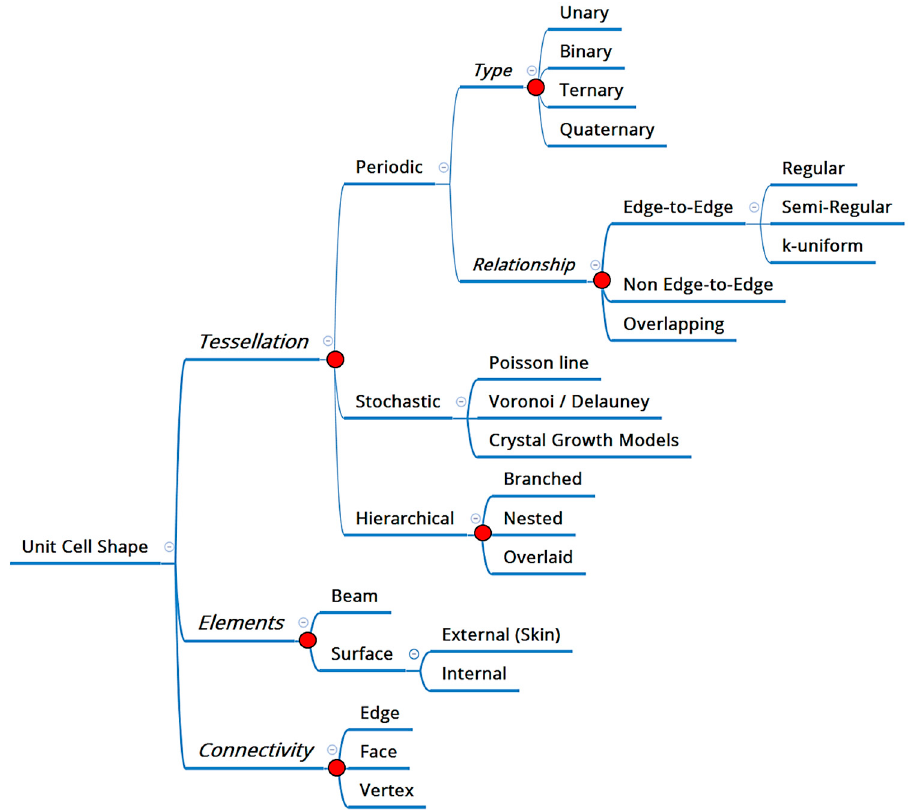
Figure 8. Cellular material classification developed by the authors from a synthesis of schemes from many domains. Each dot represents a decision point.